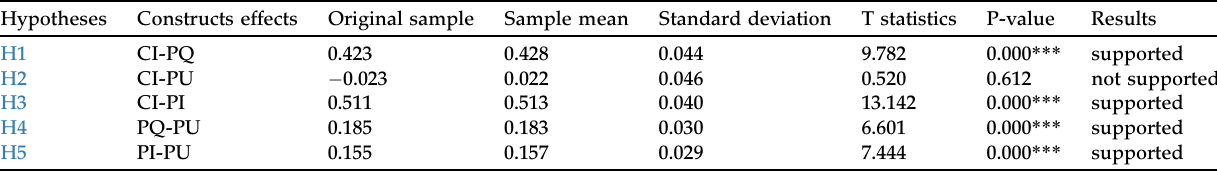
Table 4. Path coef fi cient of the structural model, direct and total effects of constructs. Hypotheses